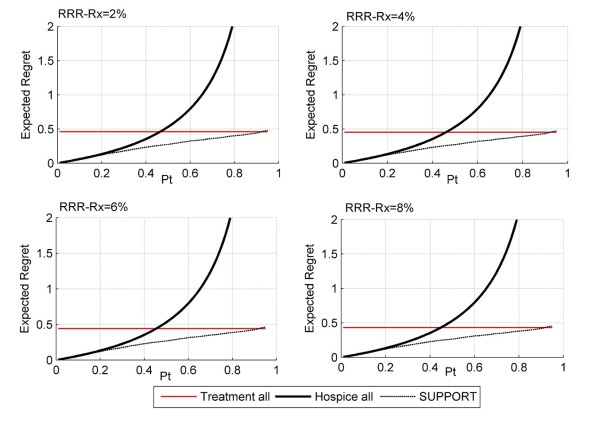
Decision curves as a function of RRRRX. In this figure, RRRHosp = 0, RRRRx = 2 to 8%, HRx = HHosp = Hte = 0. As the effect of treatment increases, the regret associated with treating all patients and with the SUPPORT model slightly decreases. The strategy of using the SUPPORT model to refer a patient to hospice is the action with the least amount of regret for the wider range of threshold probabilities.